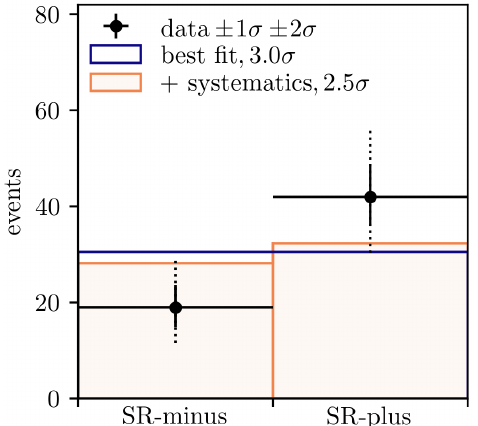
Figure 7 . Illustrated analysis of parity-opposite histograms in a minimal two-bin example. A parity-asymmetric model assigns separate expectations in each bin, so is able to fit both perfectly. The purple line shows the best fit from a parity-symmetric model, for which both expectations must be equal. The orange histogram modifies the parity-symmetric model with constrained ‘systematic’ variations, which can allow small amounts of parity violation to account for known biases or uncertainties; these variations give a slightly better fit, reducing the significance. We assign significances σ from maximum likelihood ratios by σ 2 = − 2 log[max L and L ( θ ) are the likelihood functions of two alternative 2